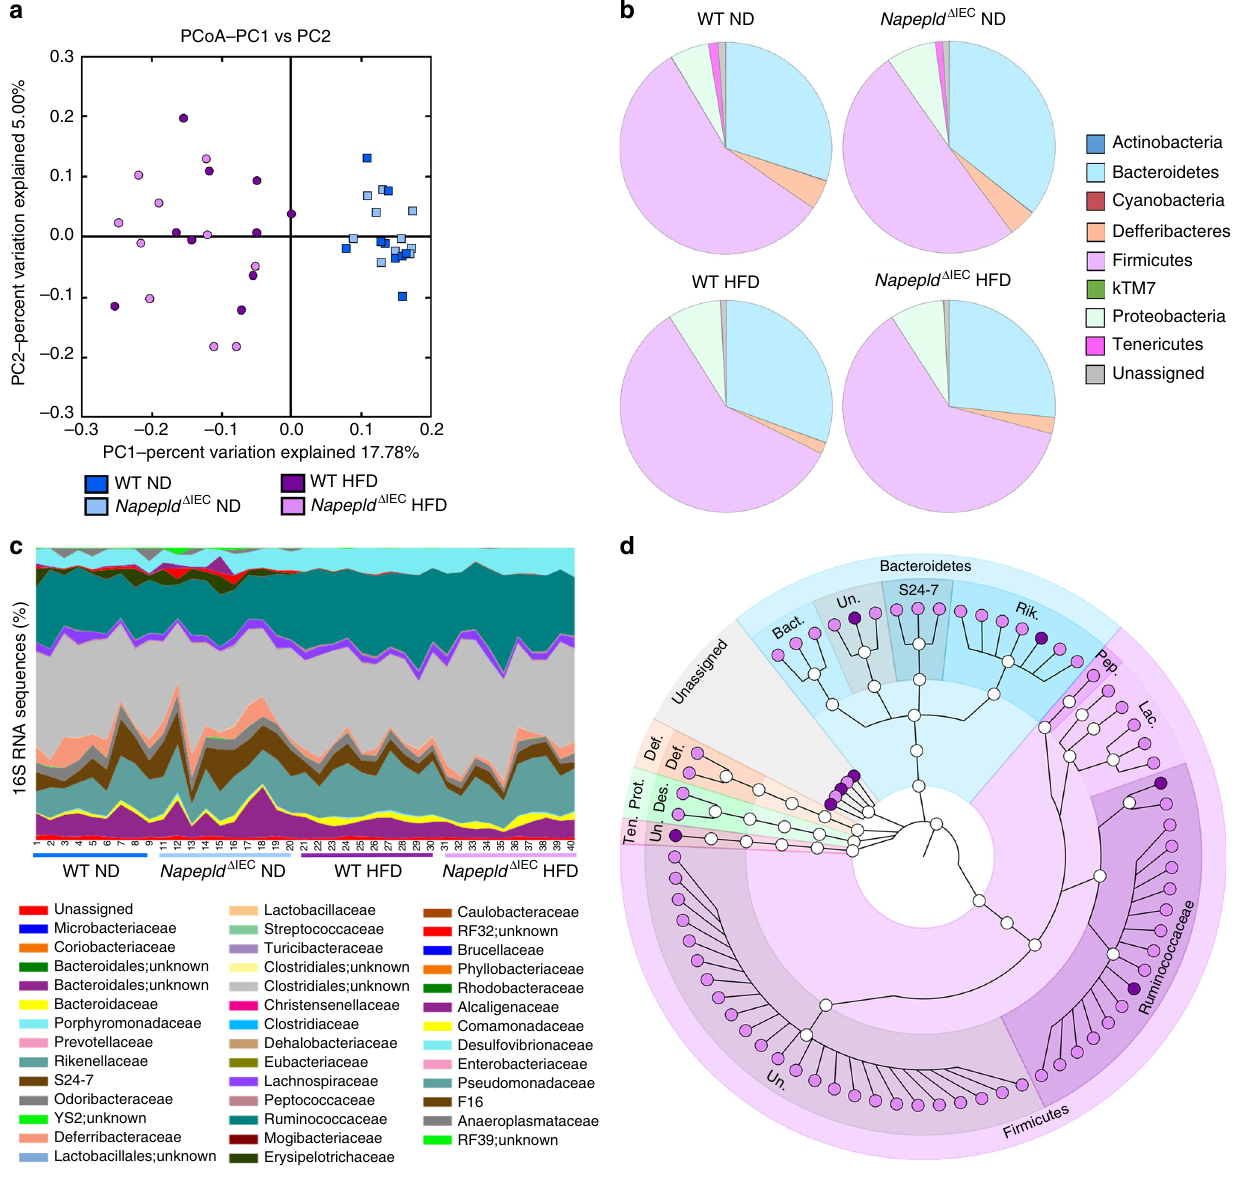
Fig. 8 Effects of IEC Napepld deletion on the gut microbiota. a Principal coordinates analysis (PcoA) based on the unweighted UniFrac analysis on operational taxonomic units (OTUs). Each symbol representing a single sample is colored according to its group. b Composition of abundant bacterial phyla identi fi ed in the gut microbiota. c Relative abundances (percentage of 16S rRNA gene sequences) of the different bacterial families in each sample. d OTUs signi fi cantly affected in HFD-fed Napepld Δ IEC mice versus WT mice. A representative 16S rRNA gene from each of the 75 differentially expressed OTUs was aligned and used to infer the phylogenetic tree shown in this fi gure ( n = 9 – 10). Purple: WT HFD mice and pink: Napepld Δ IEC HFD mice.